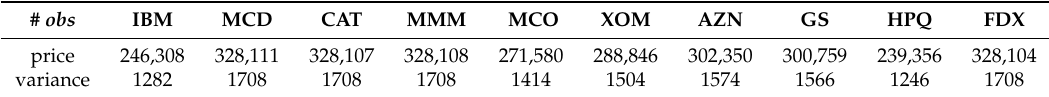
Table 4. The number of asset price and measured variance observations for the stock